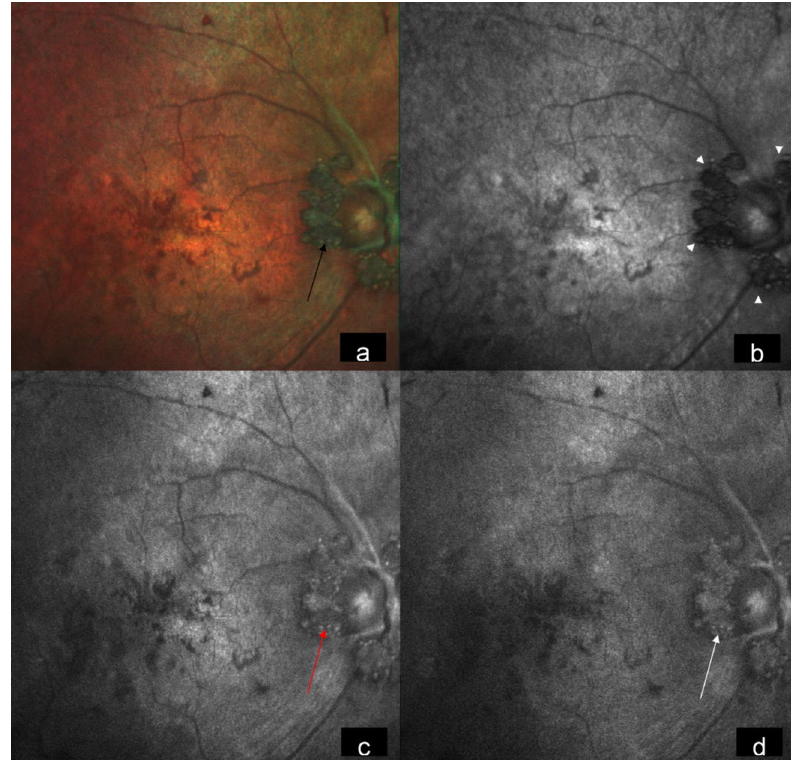
Figure 4: Multicolor image of the right eye highlighting mulberry appearance of the lesion with green shift (a) (black arrow). In Infrared reflectance, the lesion is hyporeflective with its margins well visualized (b) (arrow heads). Green reflectance (c) (red arrow) and blue reflectance (d) (white arrow) show multiple hyperreflective dots.